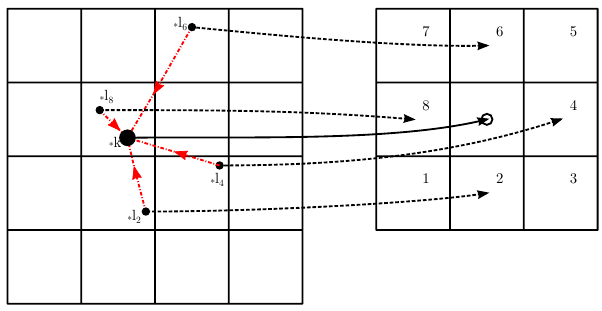
Fig. 2. Departure dependent filter in two dimensions: By redistributing mass to each neighbouring cell one by one, starting with the closest, the mass is distributed as locally as possible. For simplicity the trajectories of the four corner cells [1,3,5,7] are not shown